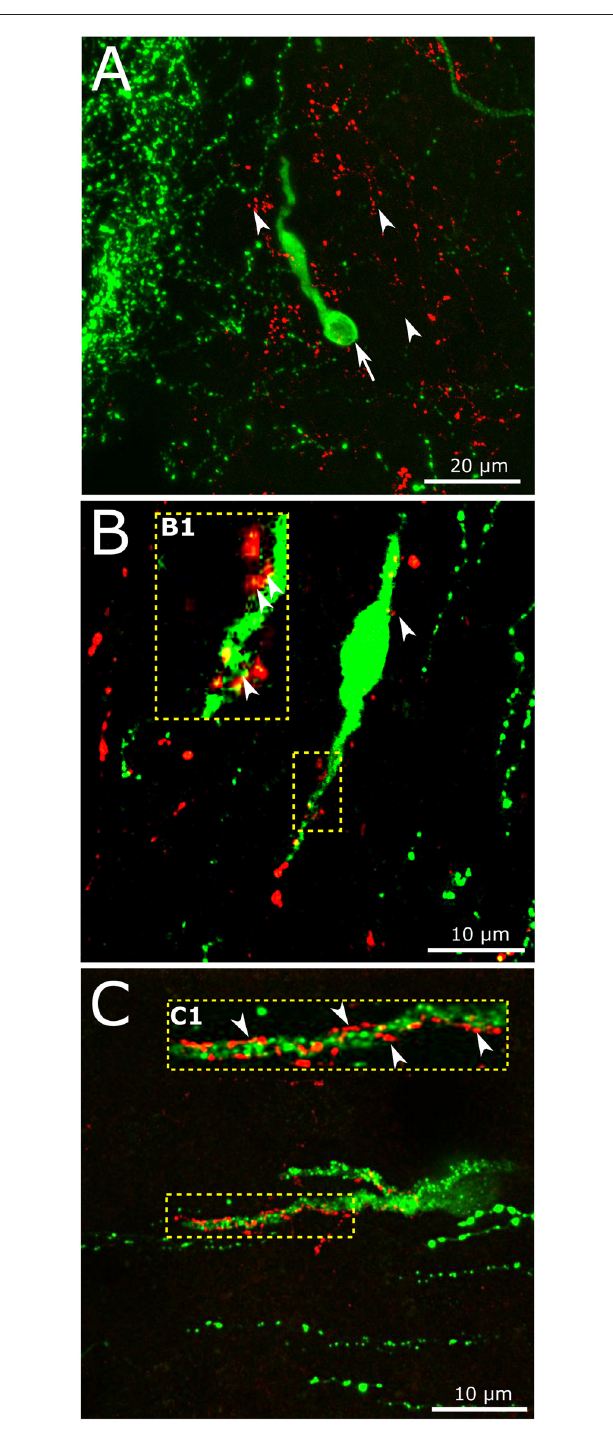
FIGURE 5 | Interaction of central GLP-1 and GnRH neuronal systems. (A) Red GLP-1-immunoreactive (IR) axons (arrowheads) and a green GnRH-IR neuron (arrows) appear in the vicinity of the vascular organ of lamina terminalis (OVLT) of the mouse brain. (B,C) GLP-1-IR axons establish contacts with the dendrites (enframed by dotted line) of a subset of GnRH neurons exhibiting smooth (B) or rough (C) surface. The multiple contacts (arrowheads) are shown at higher power in insets (B1,C1)